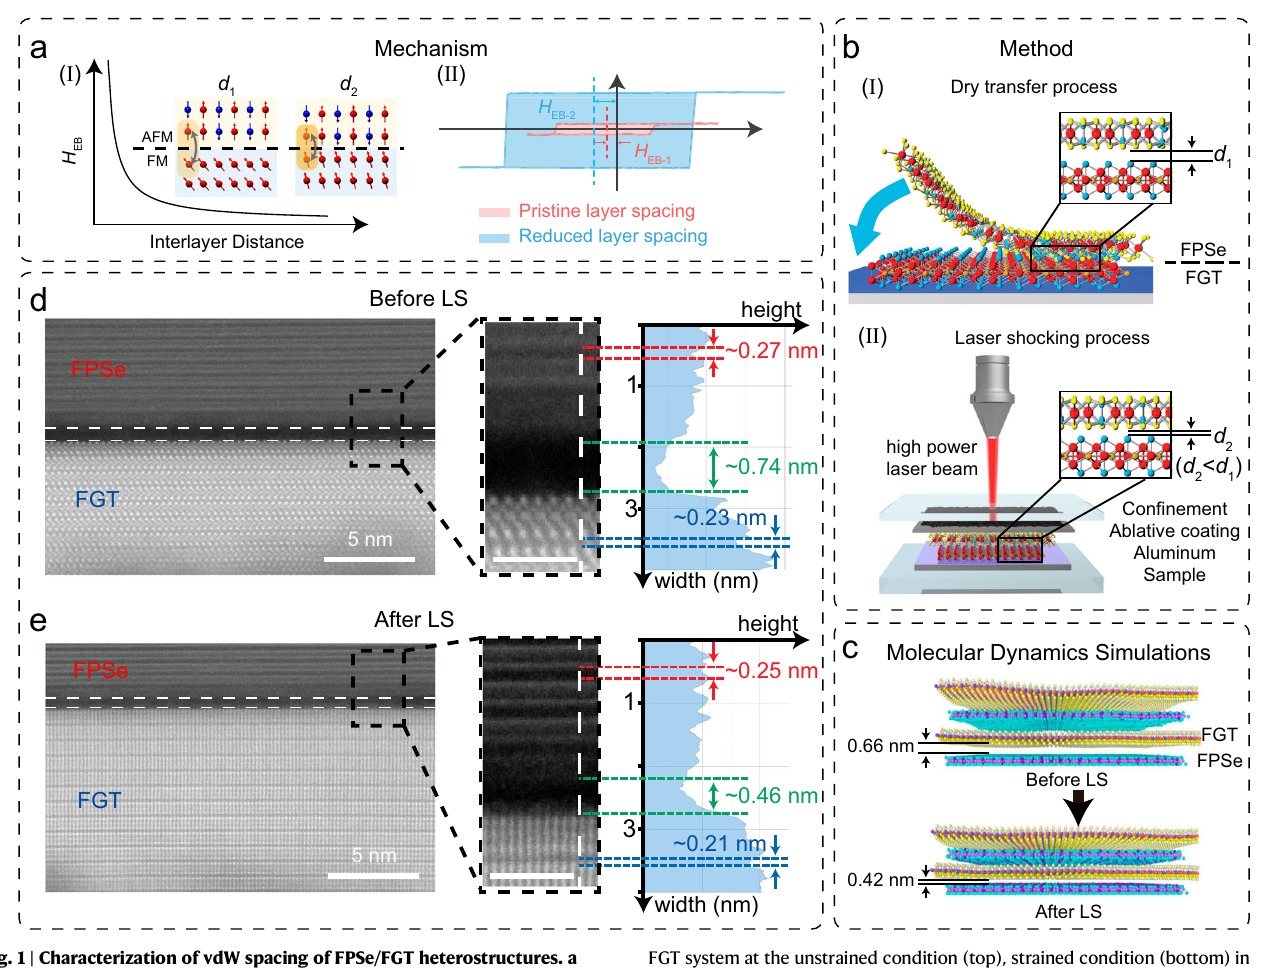
FGT system at the unstrained condition (top), strained condition (bottom) in molecular dynamics simulations. d , e The cross-sectional HAADF-STEM image of the FPSe/FGT heterostructure before ( d ) and after ( e ) LS. Inset: intensity pro fi le (right panel) along white dashed line in the cross-sectional HAADF-STEM image (middle